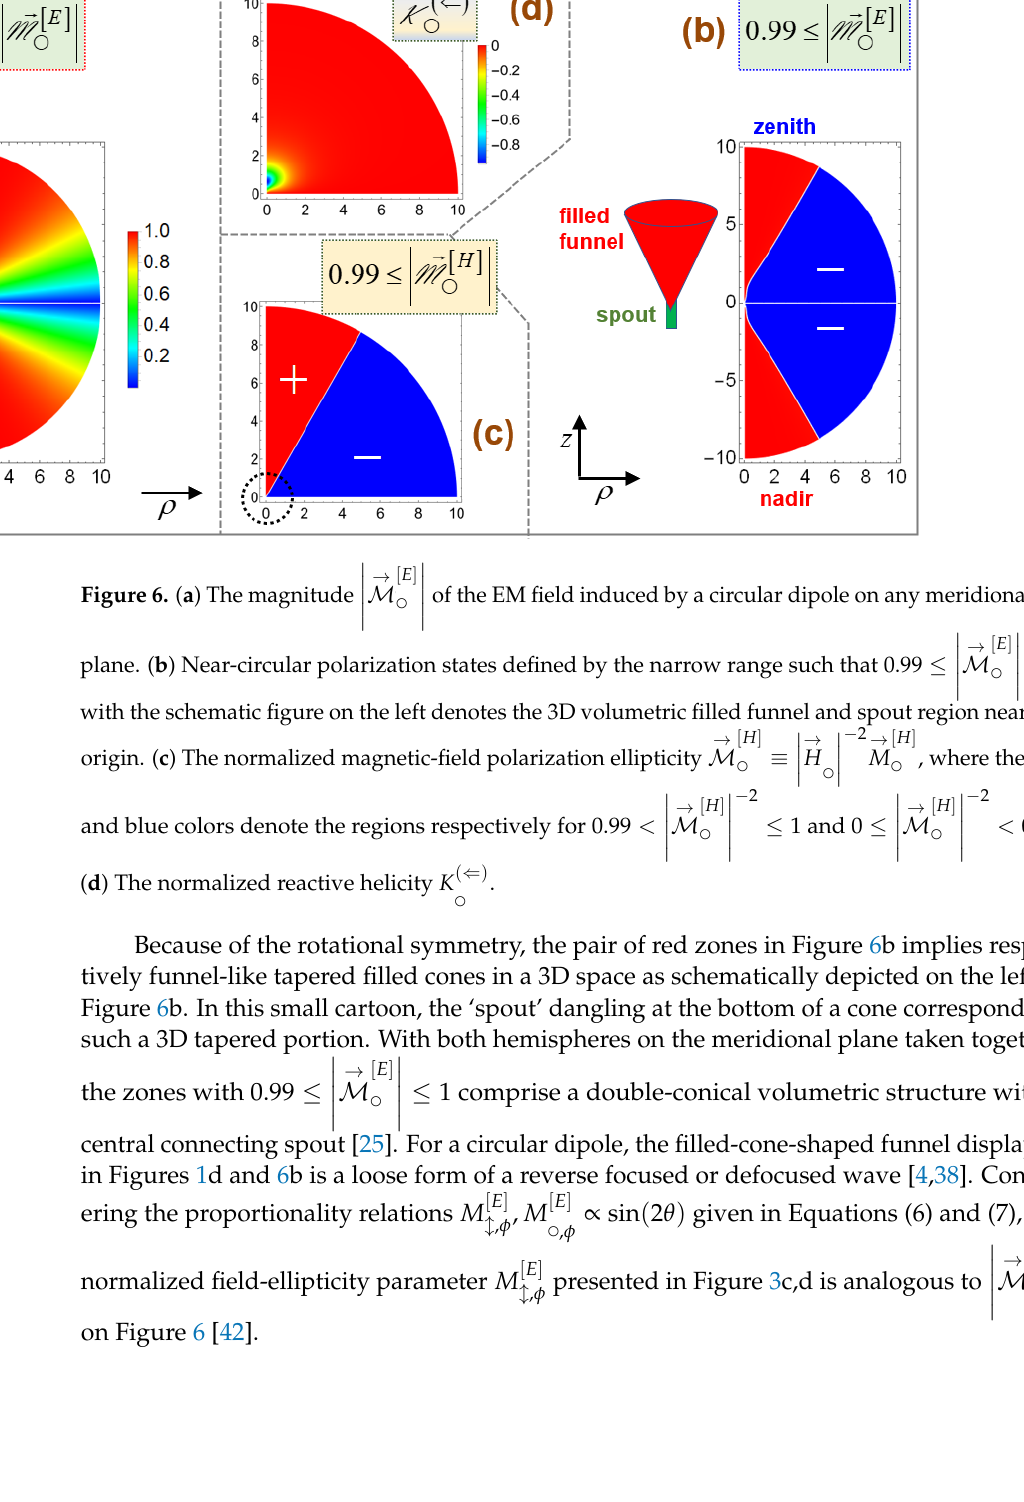
of the total SAM density is nothing but the helicity conservation